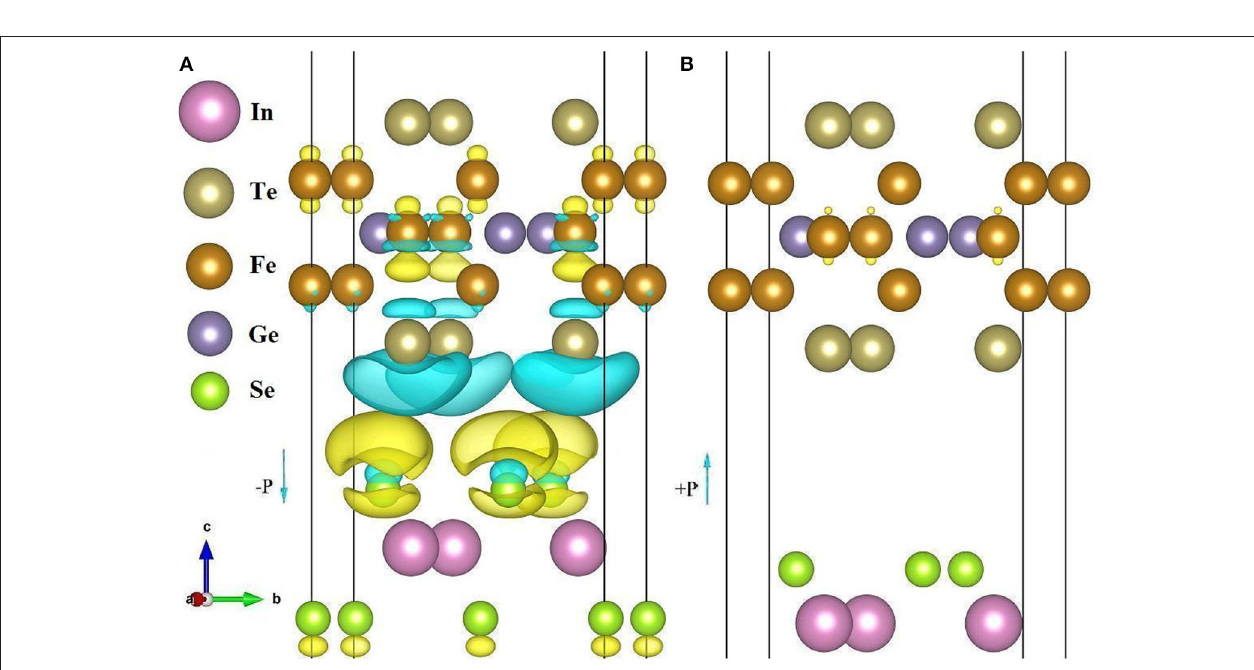
P cases (B) . The isosurface value is set to be 0.00035 e/ bohr 3 . +